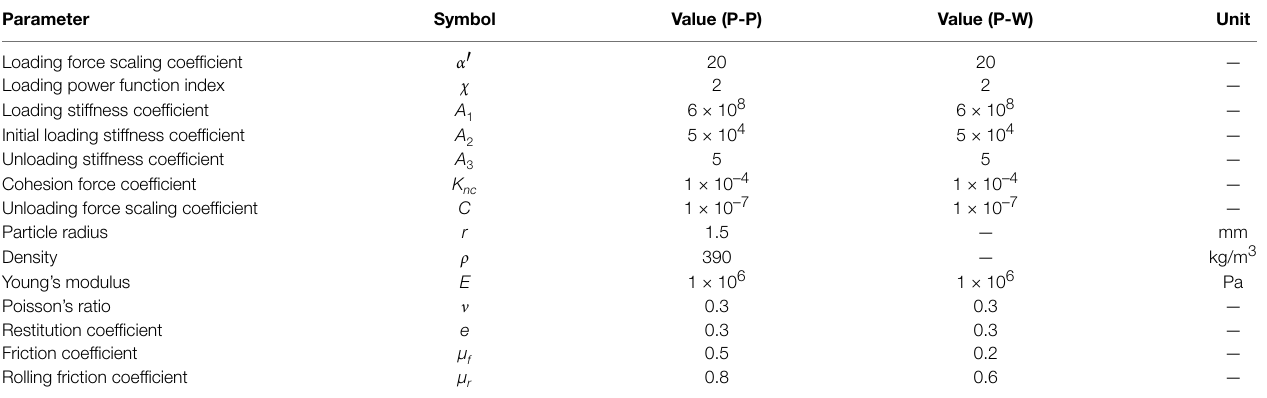
TABLE 2 | Calibrated DEM model parameters for loblolly pine chips.